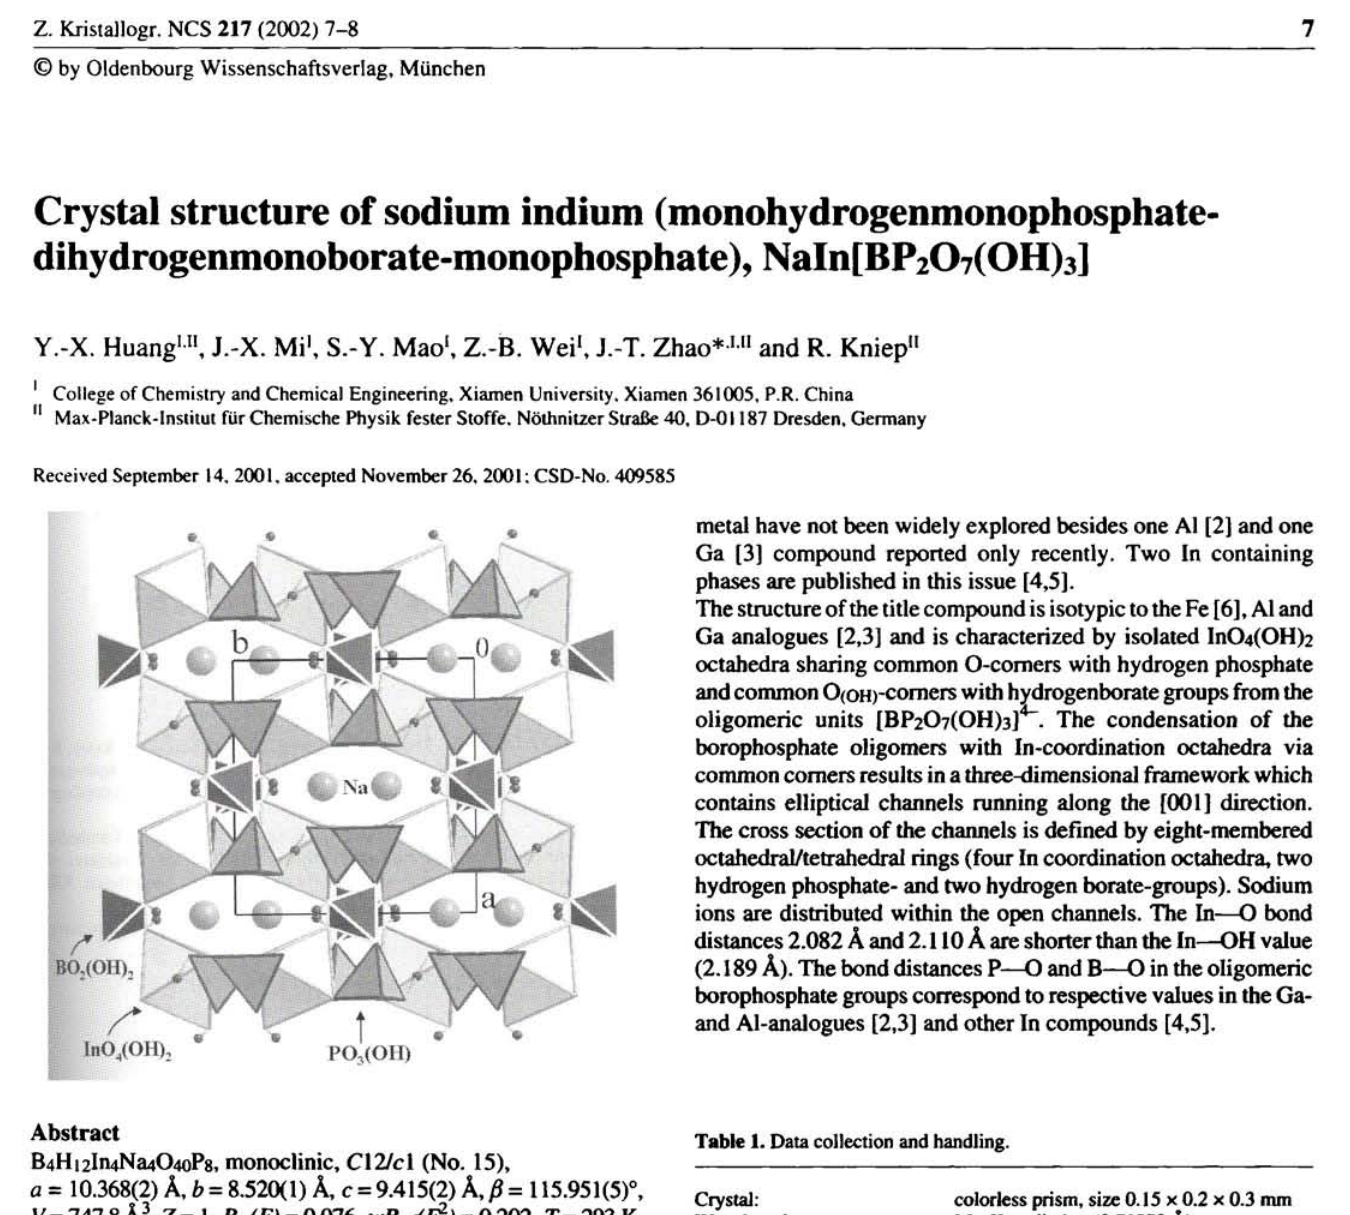
Table 1. Data collection and handling.